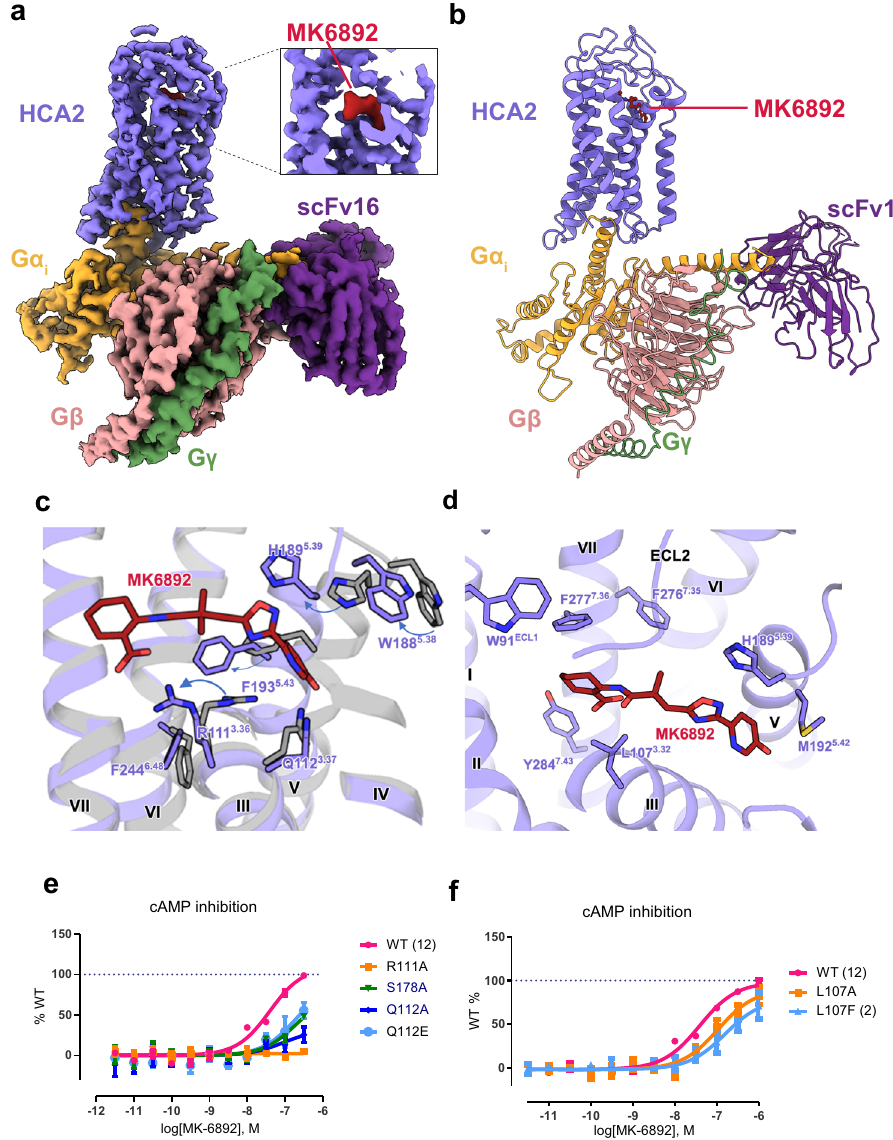
Fig. 1 | Cryo-EM structure and binding pocket of HCA2-G i complex. a Cryo-EM map of HCA2-G i complex colored by subunit (HCA2, light purple; MK-6892, red; heterotrimeric G i , orange, pink and green for α , β and γ , respectively; ScFv16, velvet).BoxindicateszoomedinviewofMK-6892. b Determinedcryo-EMstructure of HCA2-G i complex in model cartoon performance. c Zoom in superposition of MK-6892 bound state and inactive state HCA2 structures with the conformation